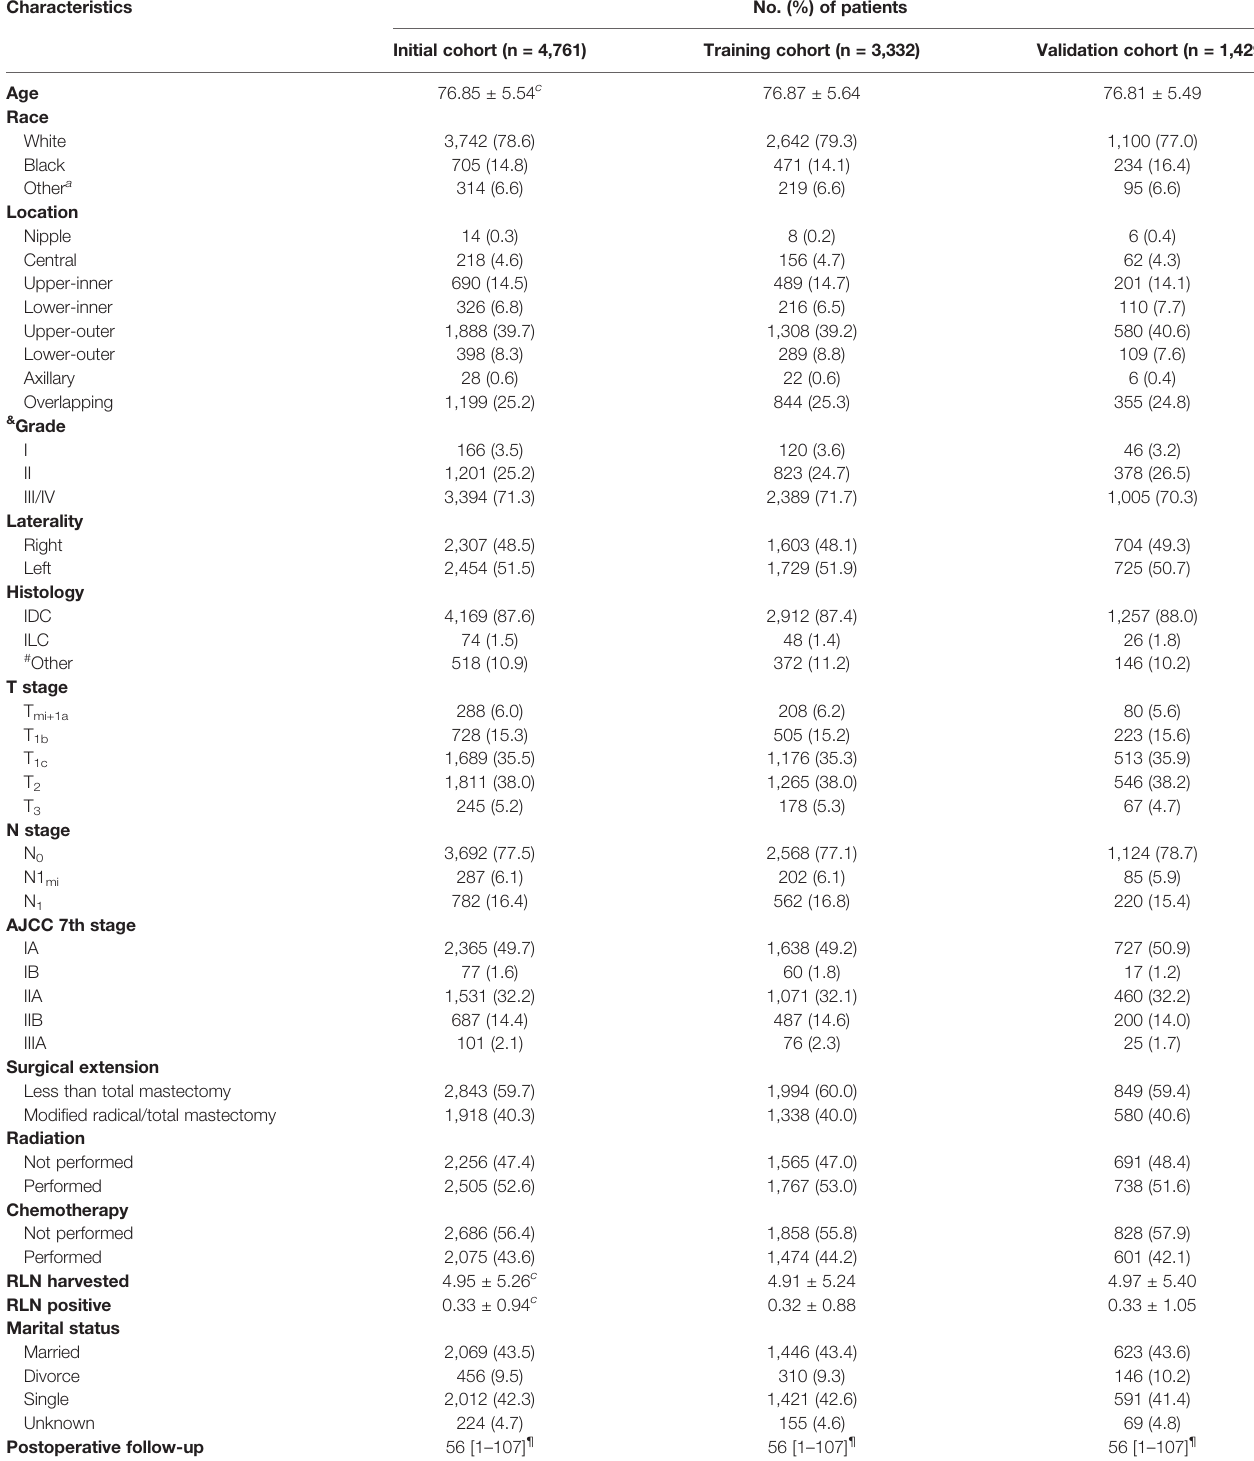
TABLE 1 | Clinicopathological characteristics of elderly primary operable TNBC patients ( ≥ 70 years old) in training and validation cohorts.